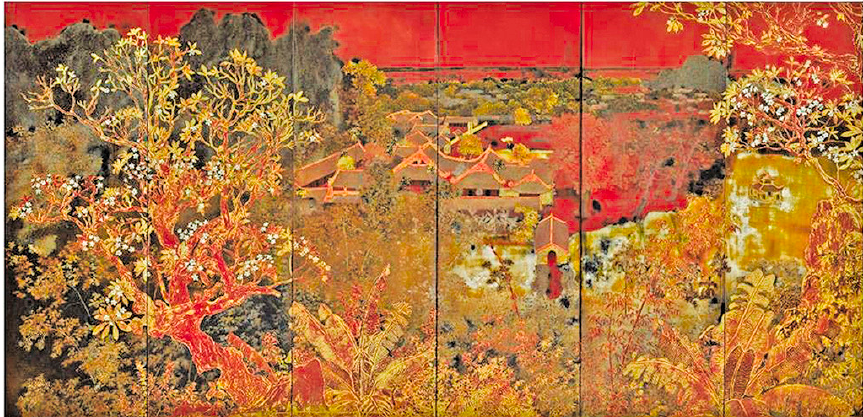
Figure A24. Phong canh —Nguyen Gia Tri. Auctioned at Sotheby’s, September 2017. The image was sourced from Thanh Nien Newspaper (Nguyen 2017c).